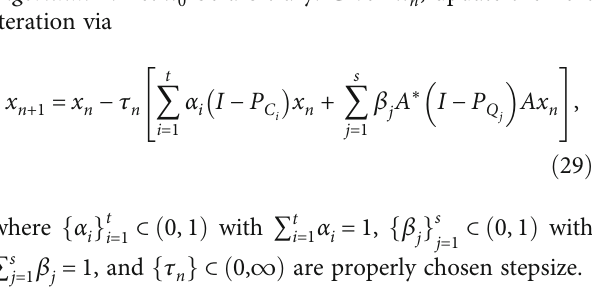
Algorithm 3. For an arbitrary initial guess ð x 0 , y 0 Þ , de fi